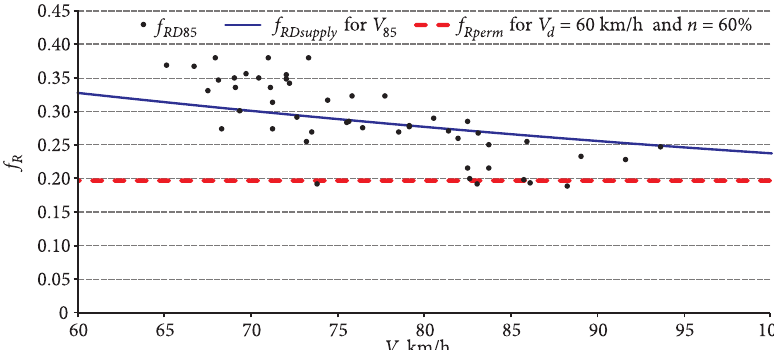
Fig. 5. The relationship between side friction demand, supply and maximum permissible side friction factors based on Lamm’s overall regression curve (Lamm et al.